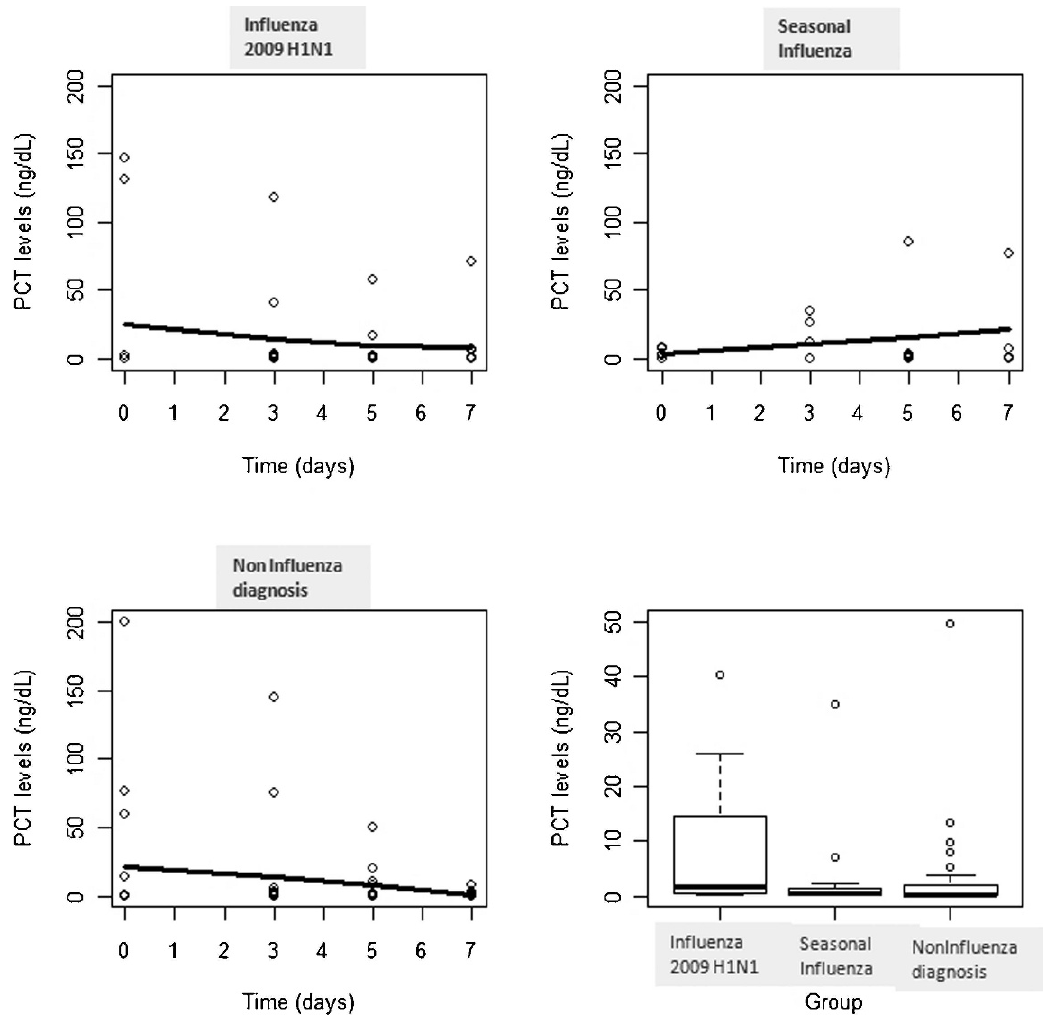
Figure 4 - The circulating levels of PCT during the first seven days of follow-up in the three